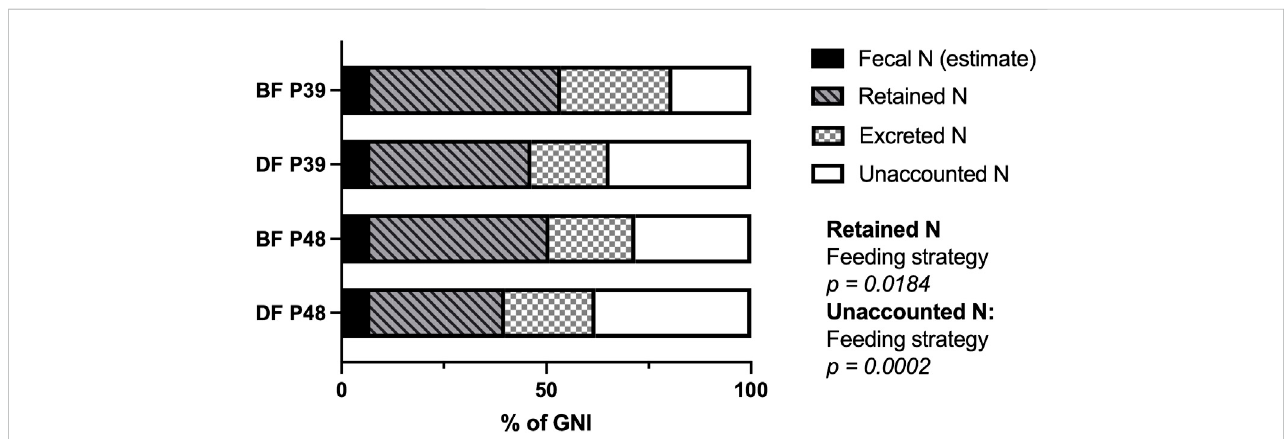
FIGURE 2 Nitrogen balances of demand-fed and batch-fed carp tanks fed at two dietary protein levels. The nitrogen (N) allocation during measuring days ( n = 60) are expressed as percentages of gross nitrogen intake (GNI) for each combination of feeding strategy and dietary protein level. The combinations of feeding strategy (DF: demand-fed, BF: batch-fed) and dietary protein content (P39: 39% protein diet, P48: 48% protein diet) are indicated on the y-axis. Signi fi cance was tested with a two-way ANOVA for each nitrogen fraction (retained N, excreted N, unaccounted N) except fecal N which was not calculated and assumed as constant, with the factors “ Feeding strategy ” and “ Dietary protein level ” .Feeding strategy had a signi fi cant effect on the percentage of retained N ( p = 0.0184) and the percentage of unaccounted N ( p =